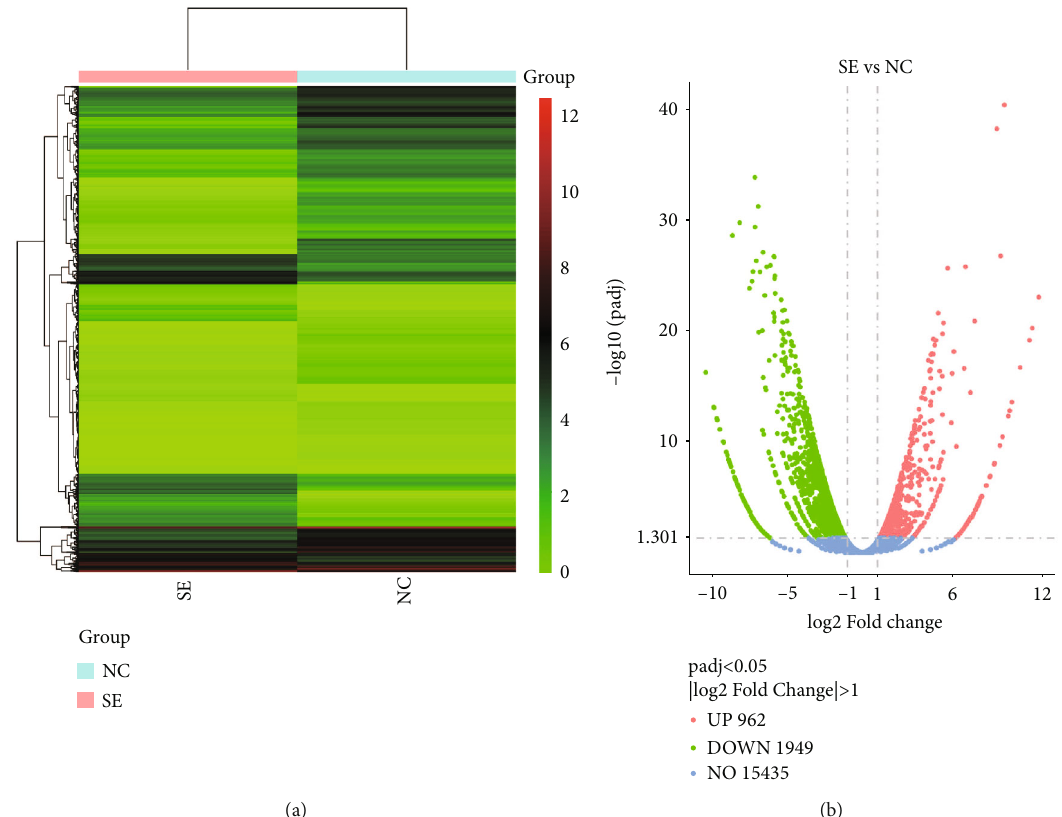
Figure 2: Bioinformatics analysis of DEGs. (a) Heat map. The horizontal coordinates are the samples, and the vertical coordinates are the normalized values of the di ff erential gene FPKM. The redder the color, the higher the expression, and the greener the color, the lower the expression. (b) Volcano map. The horizontal coordinates are the log2FoldChange values, the vertical coordinates are − log 10 p adj values, and the blue dashed line indicates the threshold line for the DEG screening criteria. SE: S-UNL-E group; NC: sham